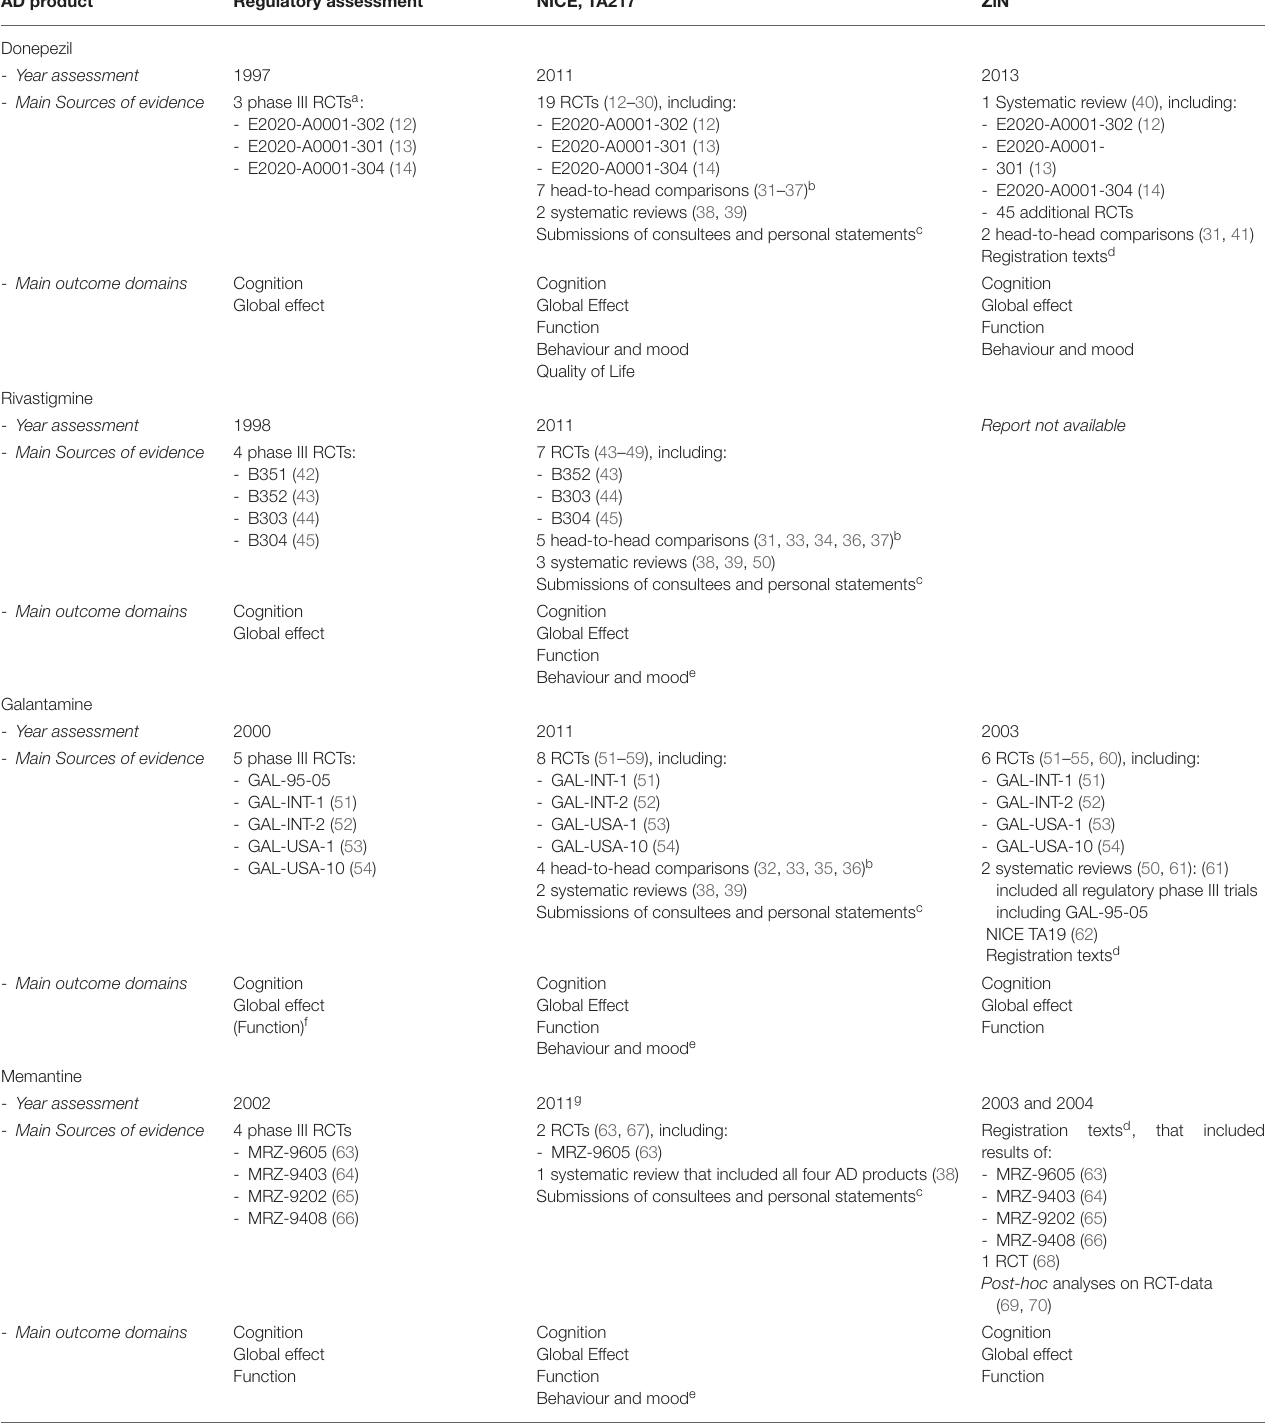
TABLE 1 | Alignment of regulatory and HTA assessments of NICE and